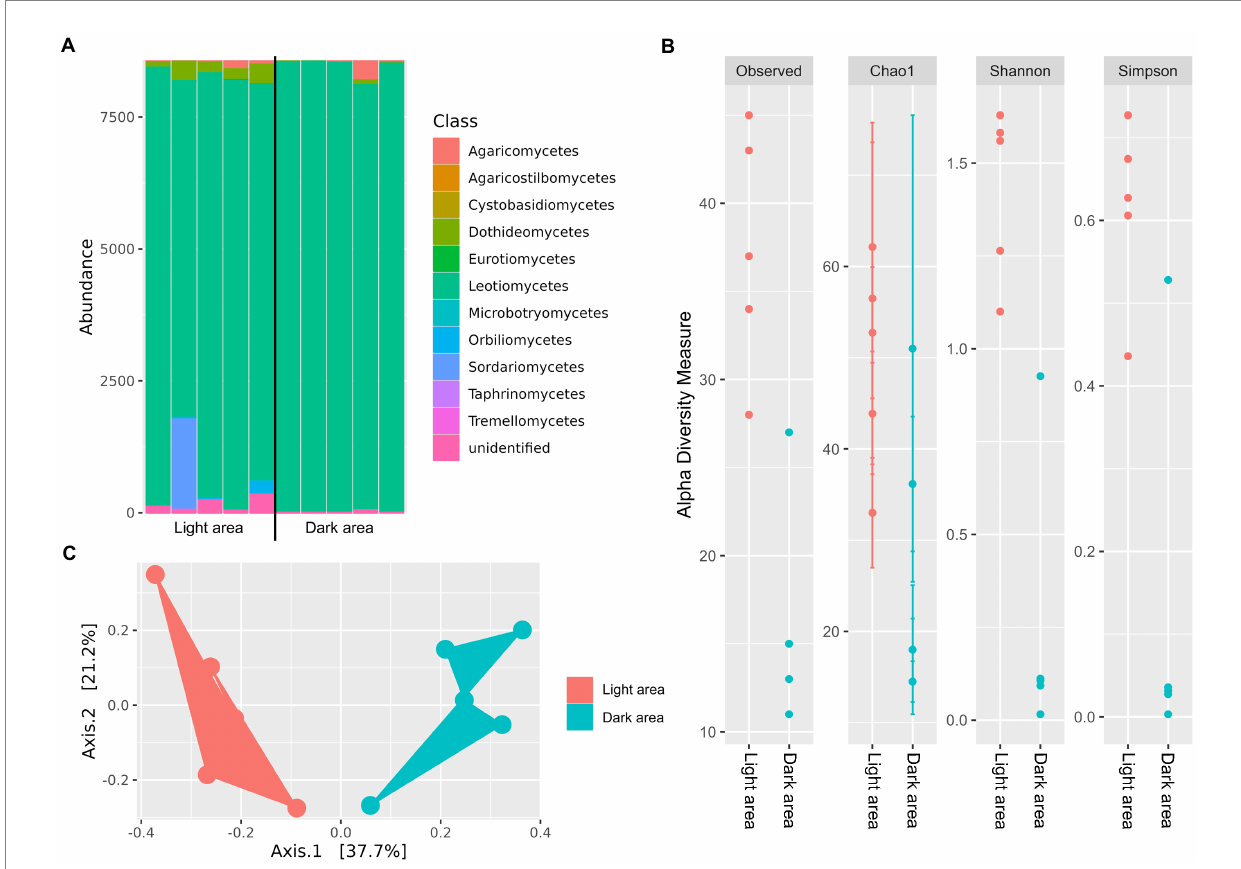
FIGURE 4 (A) Class-level distribution of the mycobiomes associated with the dark pseudosclerotial and the adjacent light reads of the petioles collected from Stjørdal in 2013, (B) alpha diversity indices of the mycobiomes from the two areas and (C) PCoA analysis based on Bray–Curtis dissimilarity matrices of the dark and light petiole area